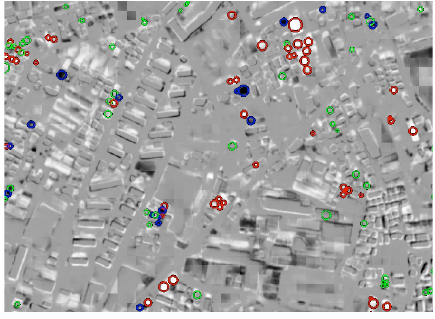
Figure 14. Overlay changes detection marks onto expected result year